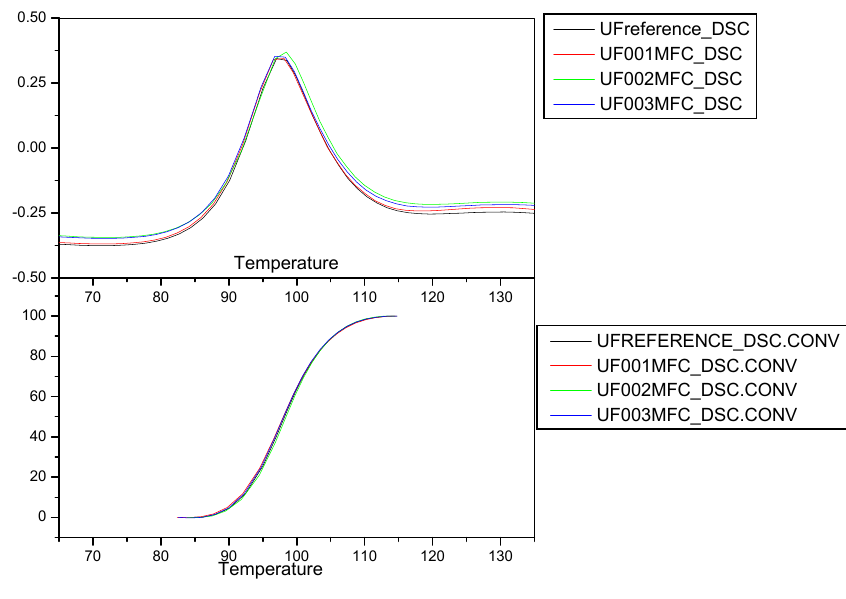
Figure 4. DSC curves, Experiment 3.1.4.